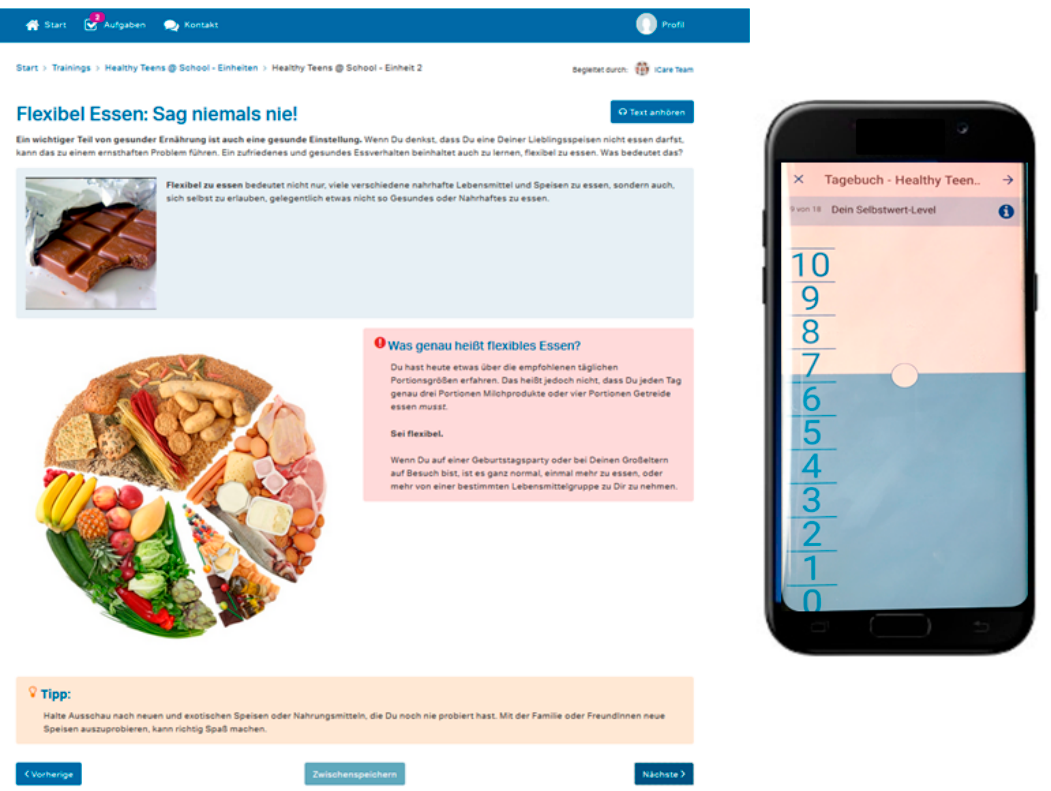
Figure 2. Screenshot of one page in module 2 of the Healthy Teens @ School program and the app- diary.